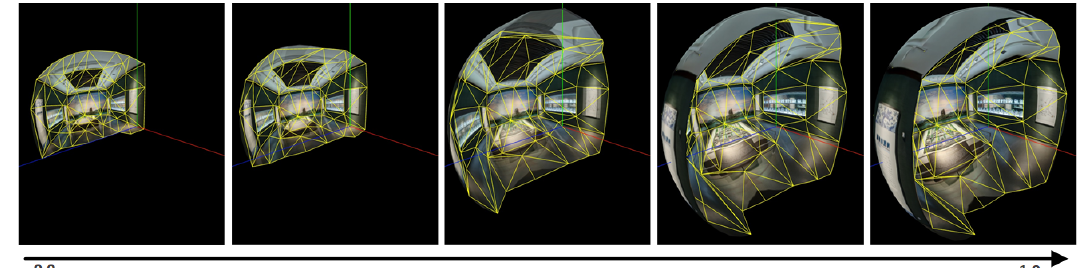
Figure 5. Middle textures generated by the smooth transition algorithm. The panorama scene transitions from the current site to the next with the process ranging from 0.0 to 1.0. The control patches transition from a small piece on the sphere to a hemi-spherical surface as the viewpoint moves forward.